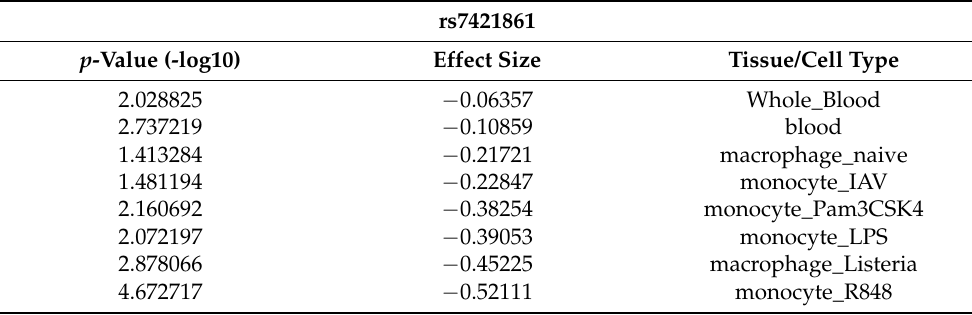
Table 7. The eQTL effect size and significance for PDCD1 rs7421861 and PD-1 expression in indicated cell types, with the variant significantly associated with suppressed PD-1 expression.